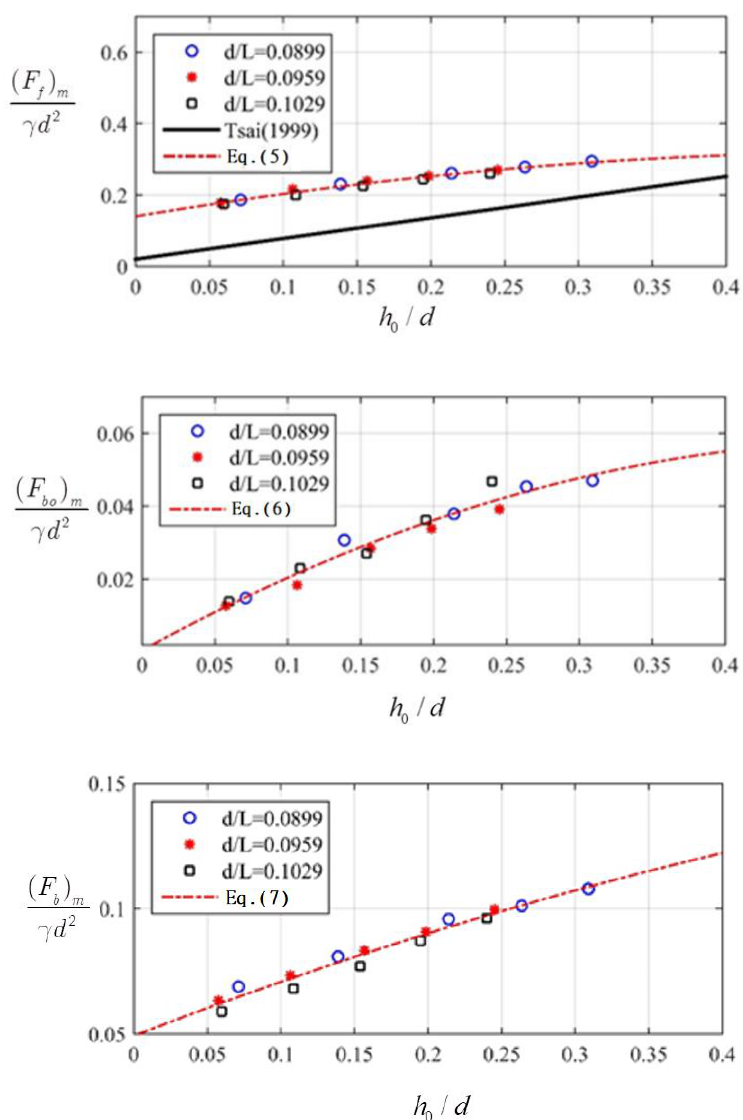
Figure 14. Maximum horizontal seaward and backward forces and uplifting force versus various dimensionless overtopping heights.